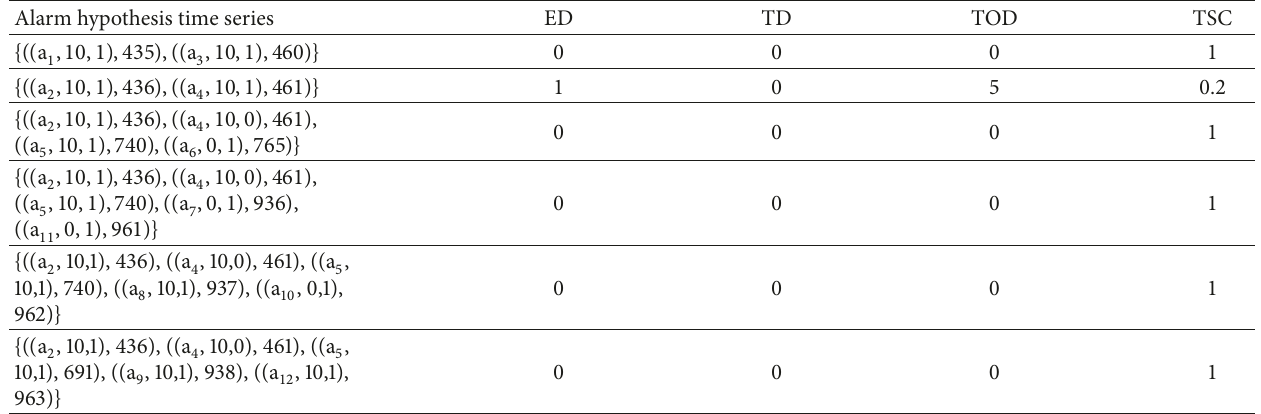
Table 7: The calculation of time series